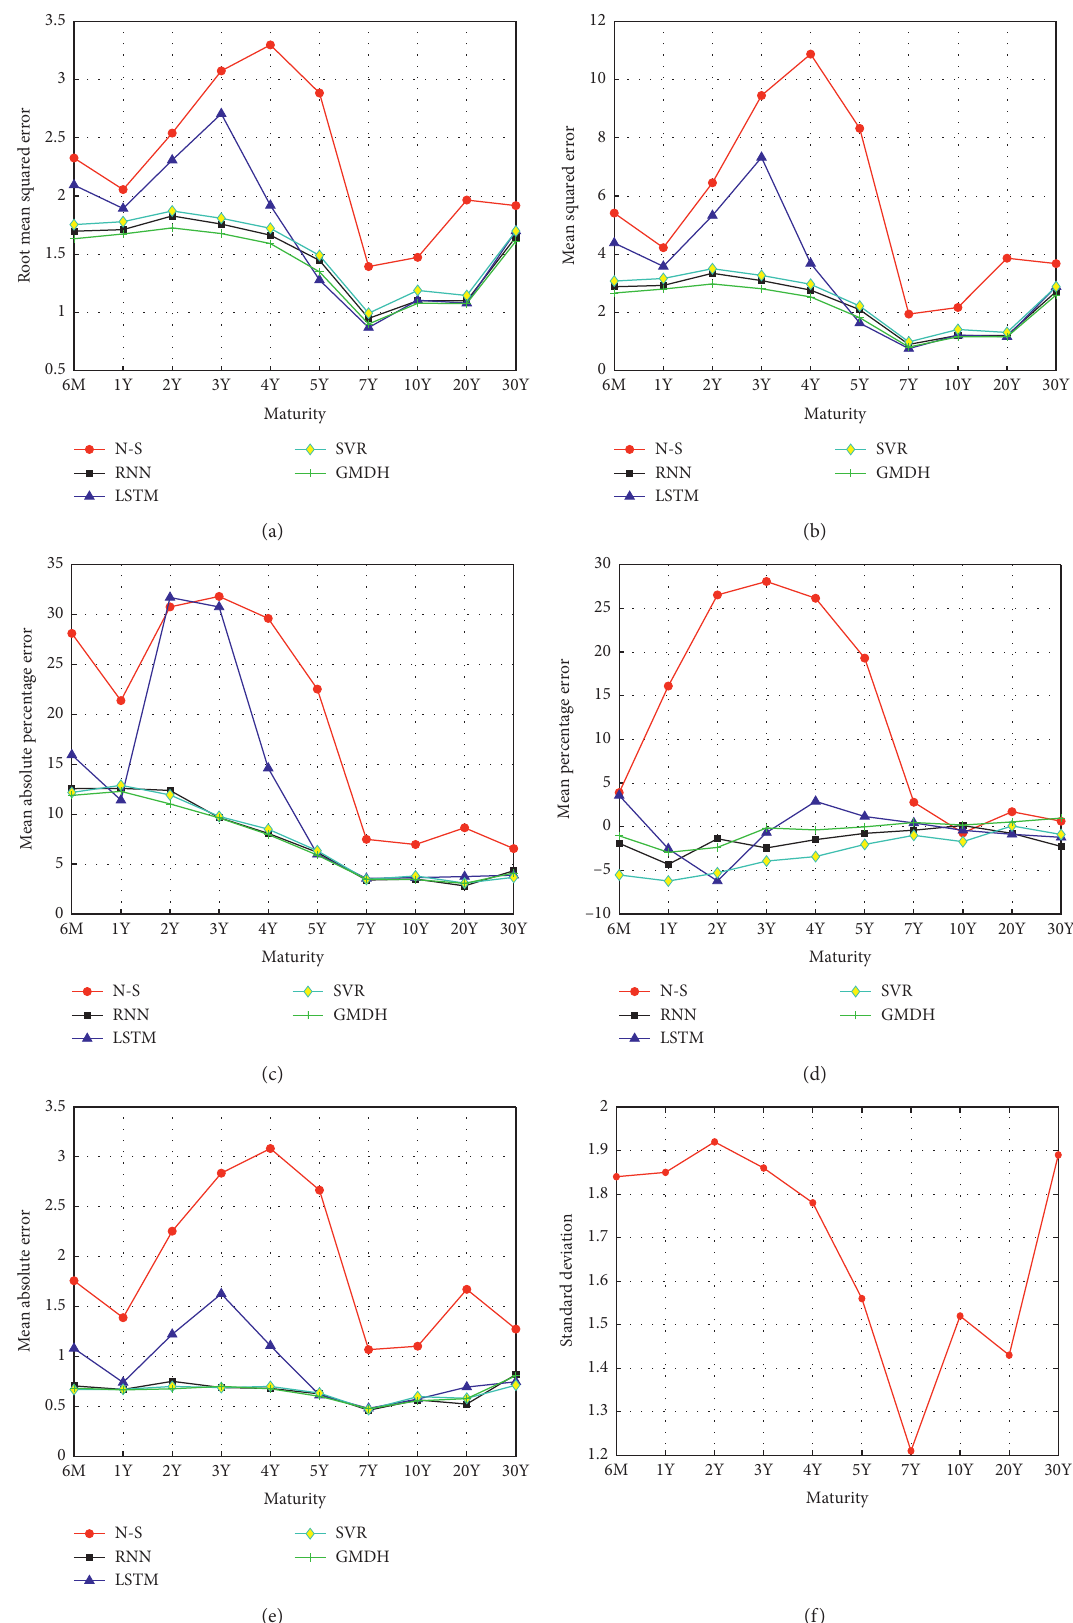
Figure 12: Error of each method for all maturities from Table 6 and standard deviations for all maturities (case 1): (a) RMSE (full period training set); (b) MSE (full period training set); (c) MAPE (full period training set); (d) MPE (full period training set); (e) MAE (full period training set); (f) test dataset